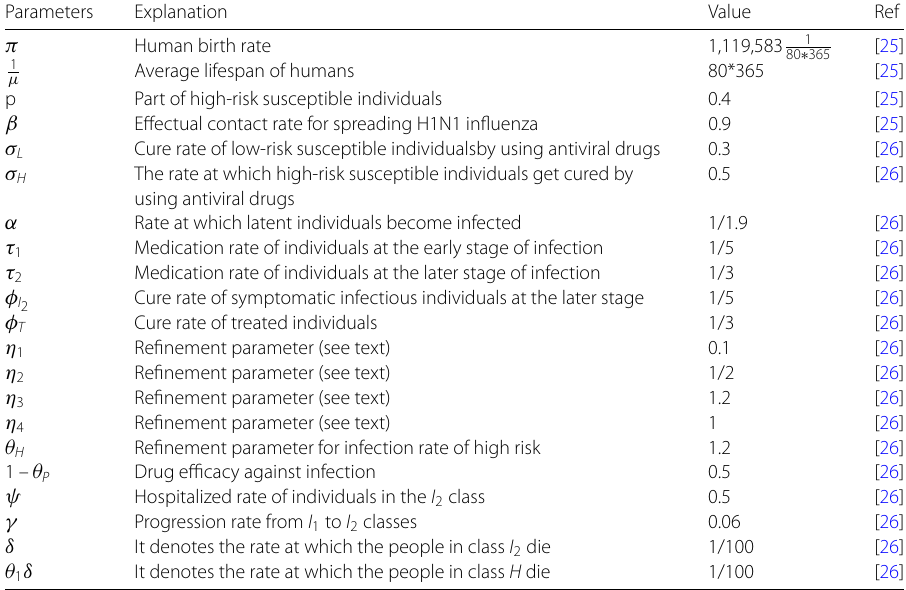
Table 1 Description of the model parameters and nominal values